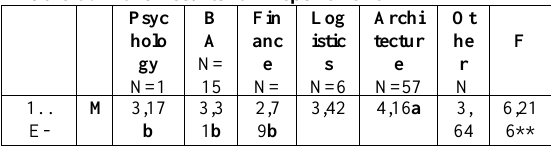
Table 6.Anova results for Department